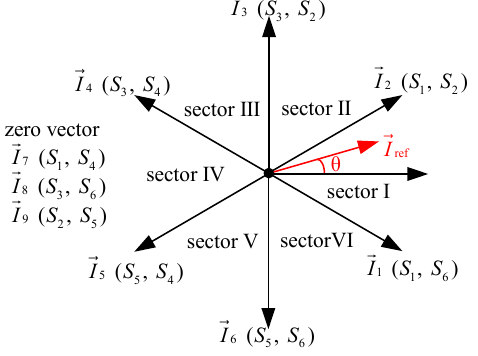
Figure 3. Space vector sector distribution.